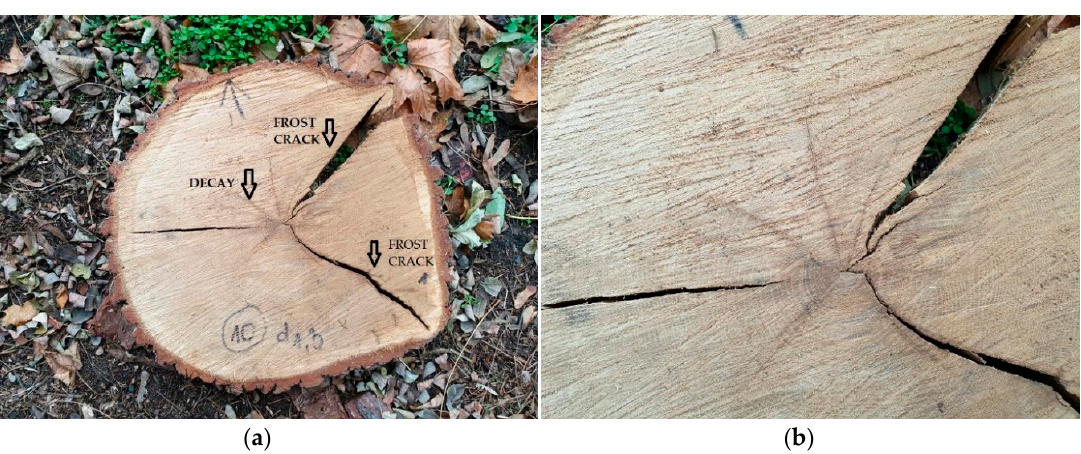
Figure 3. Sample tree number 5; DBH cross-section with frost cracks and decay: ( a ) example of a disc with two frost damage and decay; ( b ) discoloration and decay shape.